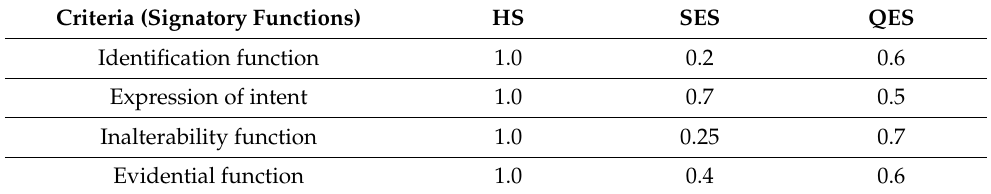
Table 3. Membership function